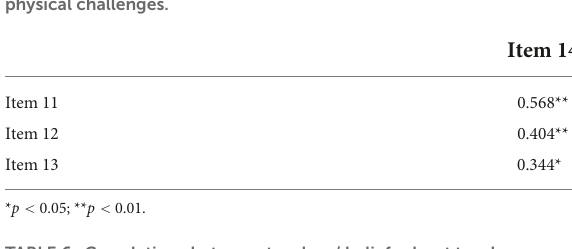
TABLE 5 Correlations between teachers’ beliefs about physical challenges.